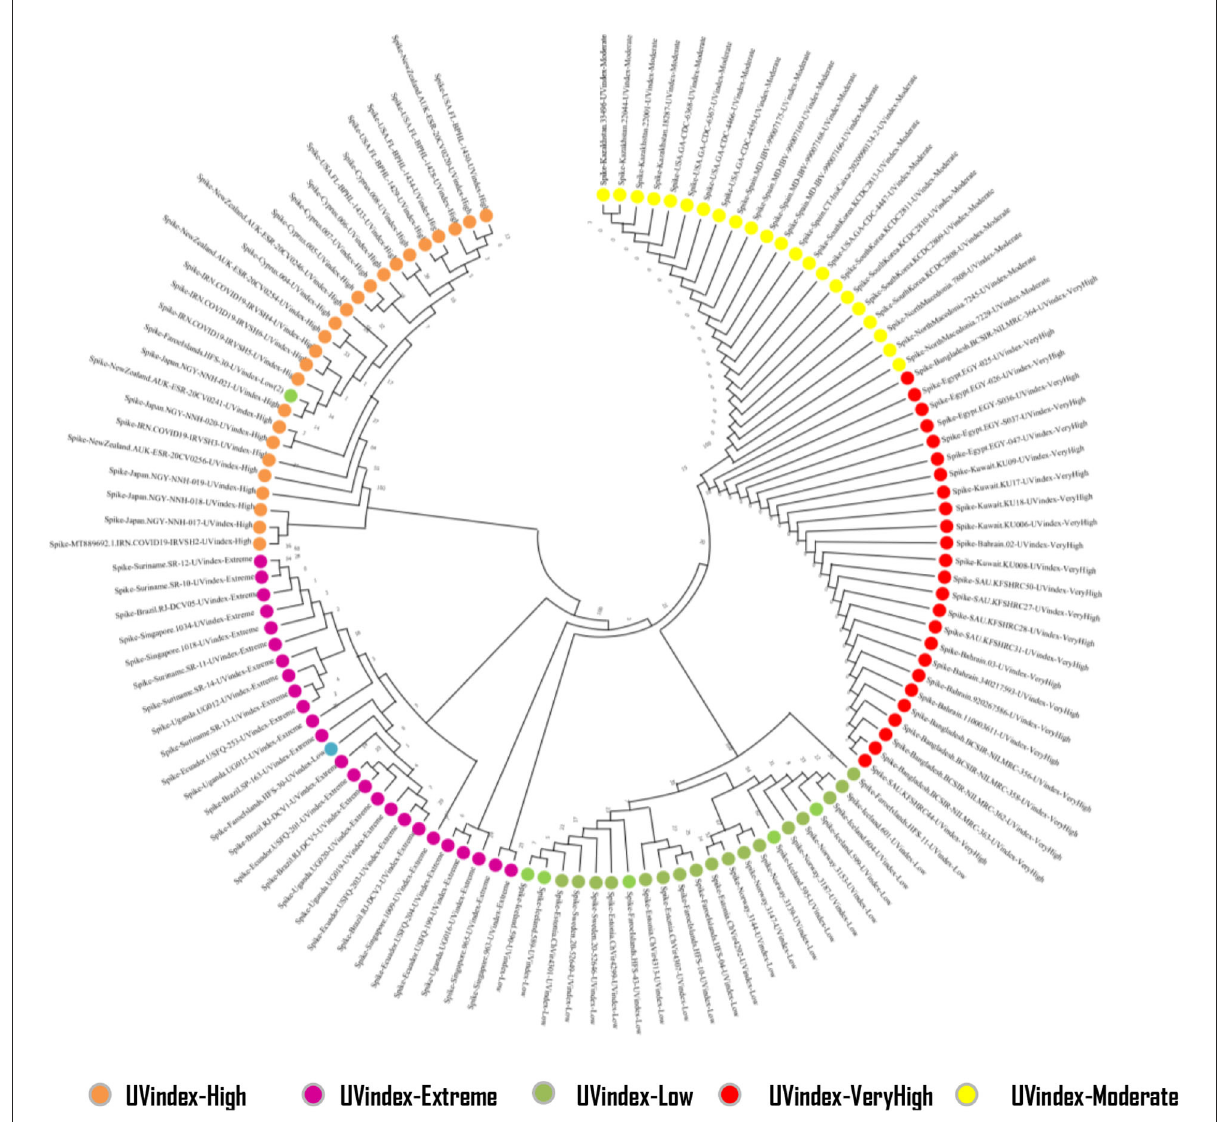
FIGURE8 Phylogenetic tree of SARS-CoV-2 genome sequences prevalent in five different UVindex regions. The five beta corona viral populations constituted five different clades. The SARS-CoV-2 population from high UVindex regions was found as the outgroup clade, whereas the SARS-CoV-2 populations from extreme, low, very high, and high UVindex regions formed three descendant clades within the